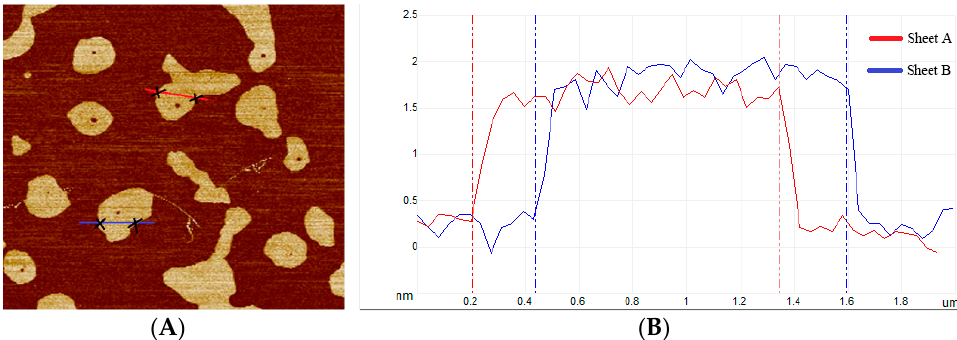
Figure 4. MEG sample cross ‐ sectional scan waveform. ( A ) Cross ‐ sectional selection; ( B ) Cross ‐ sectional waveform.